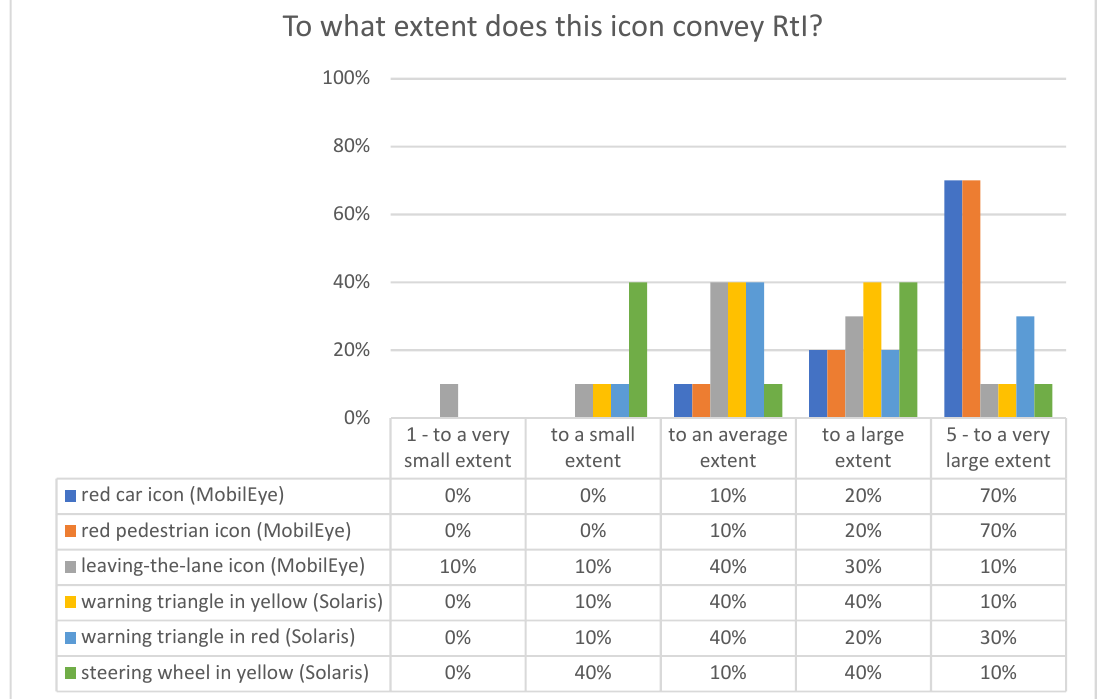
Figure 7. Comparison of the RtI alert level (MobilEye and Solaris icons).